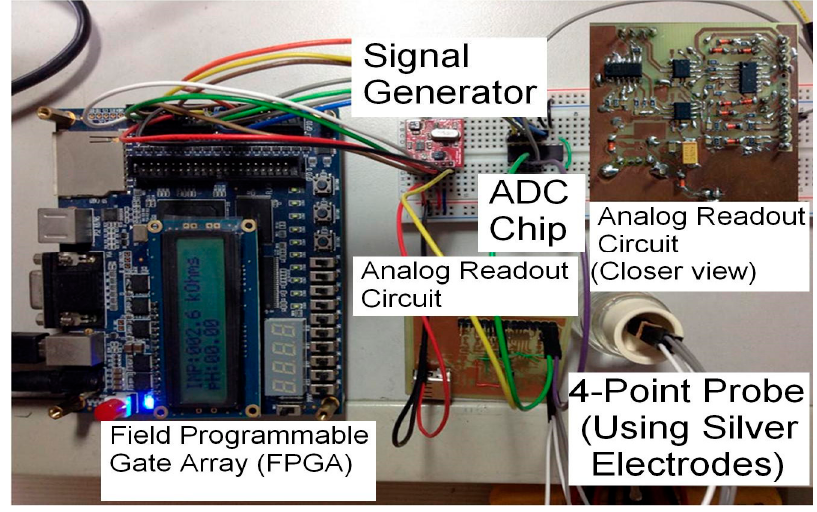
Figure 1. Portable system for use in multi-frequency electro-conductivity studies [11].